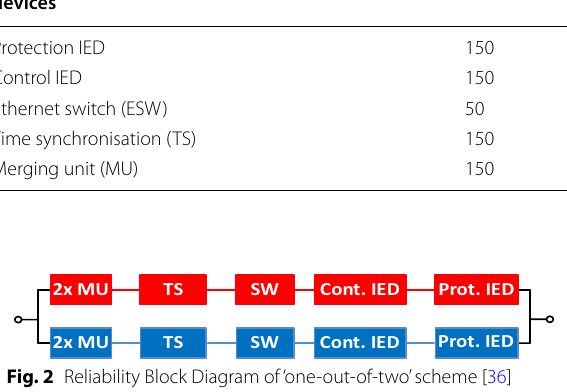
Non- func(cid:31)onal